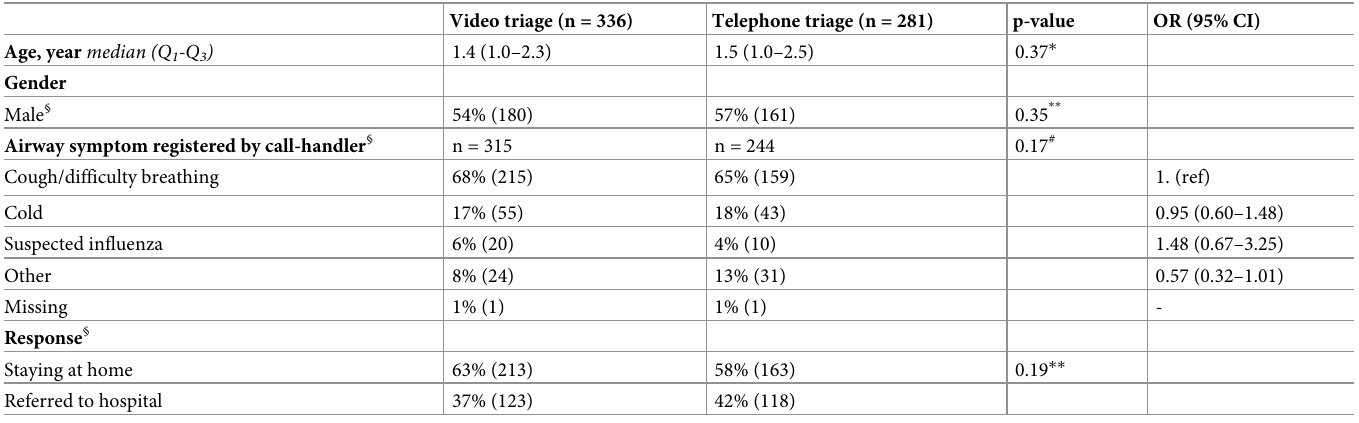
Table 1. Characteristics of patients included in video or telephone triage